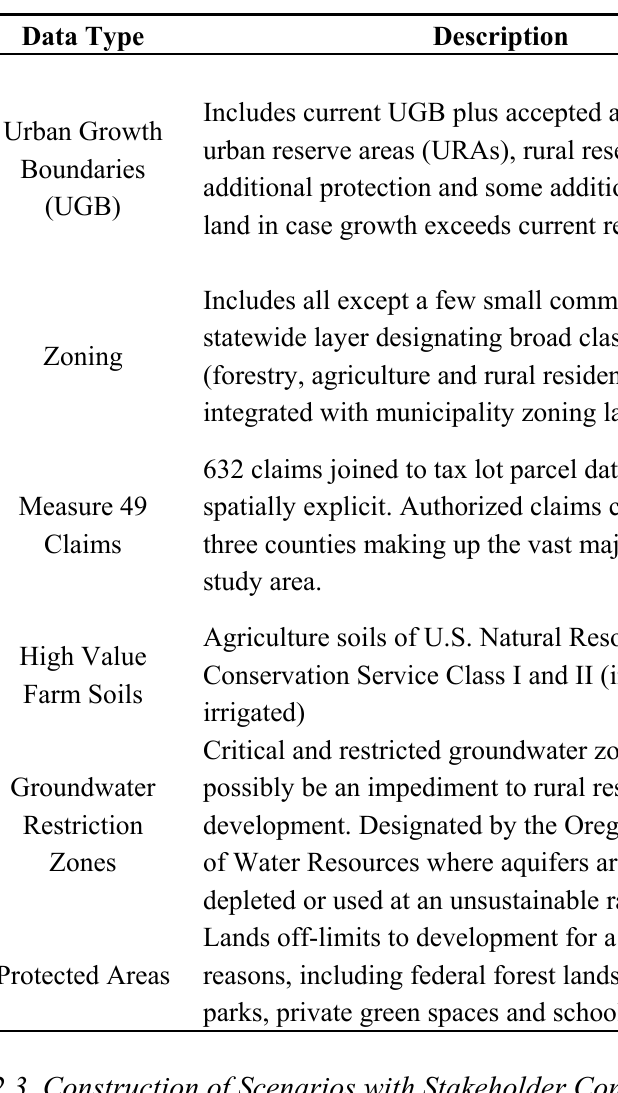
Table 3. Data sources used to create a spatial mask and graded weight map used as inputs to a model, creating future scenario maps in the study